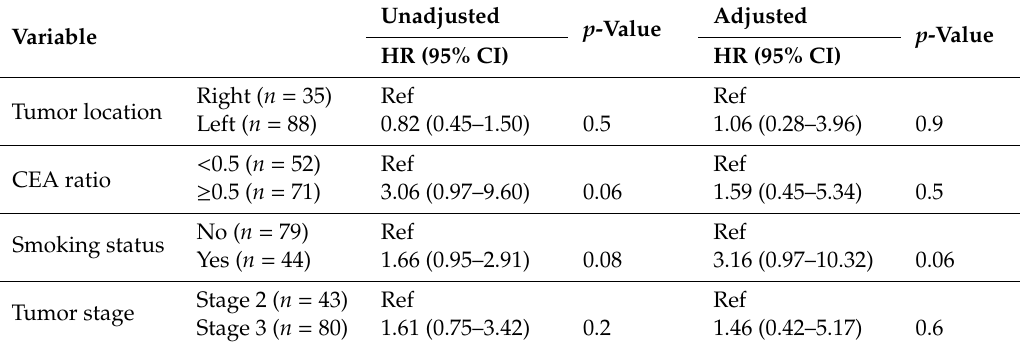
Table 2. The e ff ect of tumor location on overall survival (OS), adjusting for perioperative CEA level, smoking status, and tumor